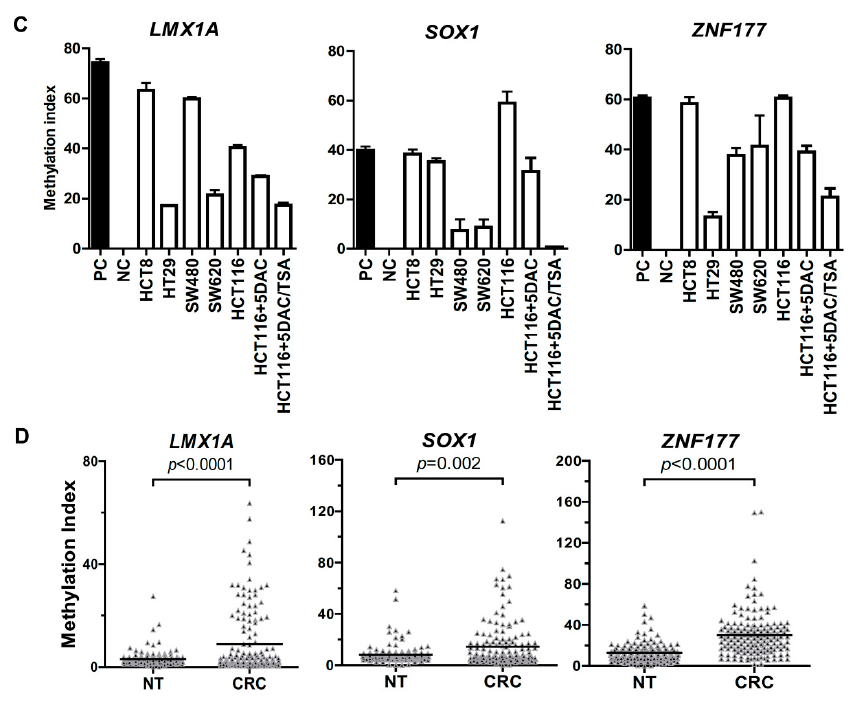
Figure 1. DNA methylation levels of LIM homeobox transcription factor 1 α ( LMX1A ), sex-determining region Y-box 1 ( SOX1 ), and zinc finger protein 177 ( ZNF177 ) in colorectal carcinoma (CRC). ( A ) DNA methylation array data for LMX1A , SOX1 , and ZNF177 in 45 tissue samples from normal individuals and 369 tissue samples from colon and rectal adenocarcinoma patients from the MethHC database are shown. The results are represented as average (AVG) β values for the probes. Black lines indicate the mean of AVG β value. The p -values for LMX1A , SOX1 , and ZNF177 methylation levels among the groups (normal versus tumor) were determined by the Mann–Whitney U test. ( B ) The promoter methylation statuses of LMX1A , SOX1 , and ZNF177 in five CRC cell lines were analyzed by MSP with methylated and unmethylated-specific primers. PC: positive control; NC: negative control. Gene expression levels of three genes and the internal reference GAPDH in HCT116 cells treated with 5 µ M DAC or 5 µ M DAC combined with 300 nM TSA (5DAC / TSA), or left untreated, were analyzed by reverse transcription polymerase chain reaction (RT-PCR). Mr: molecular marker, or DNA ladder.